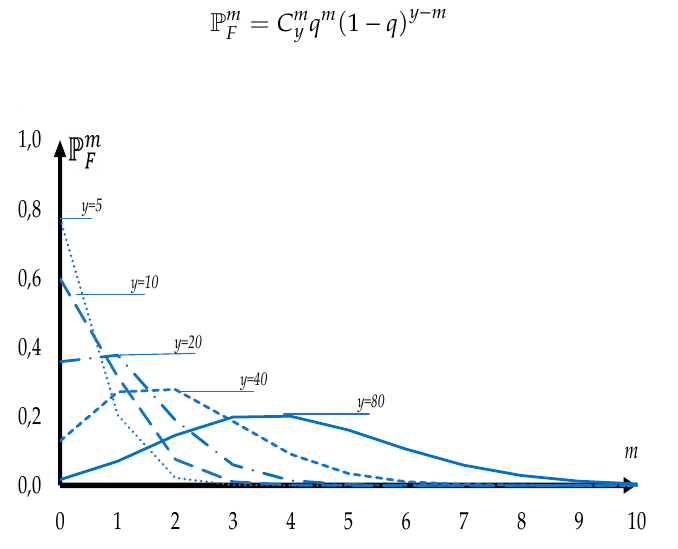
Figure 1. Binomial PDF for different numbers of generators.